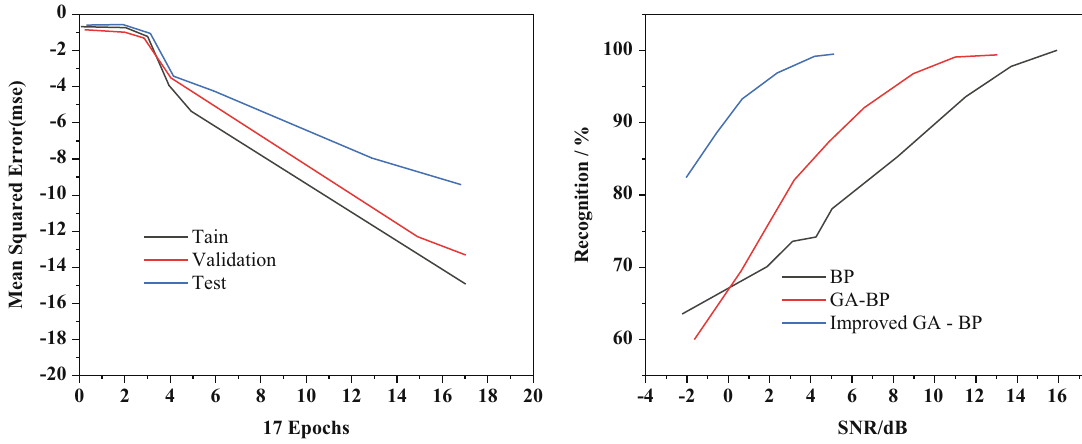
Figure 4: Convergence curve of the improved GA - BP algorithm. Figure 5: Type 1